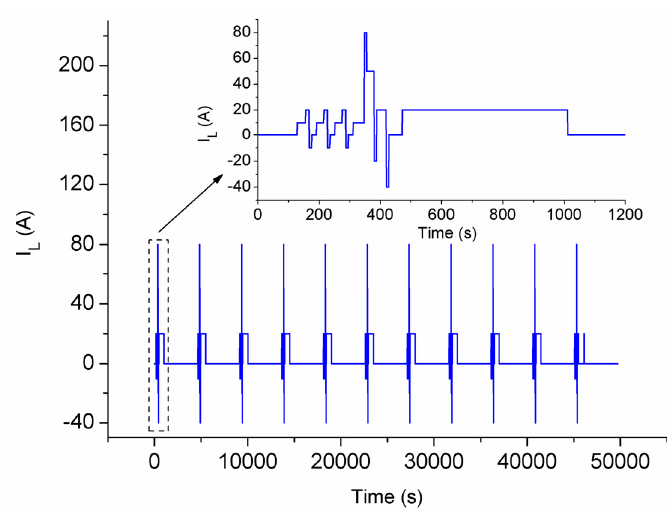
Figure 8. Model and parameter identification verification experimental